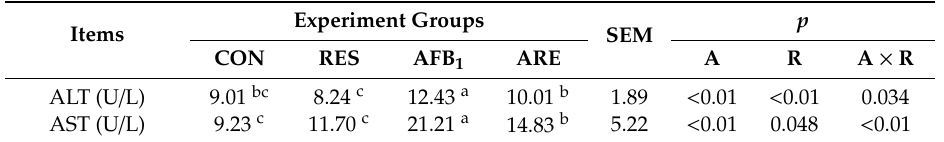
Table 3. The effect of dietary resveratrol supplementation on the activities of ALT and AST in the liver of AFB 1 -challenged mice.